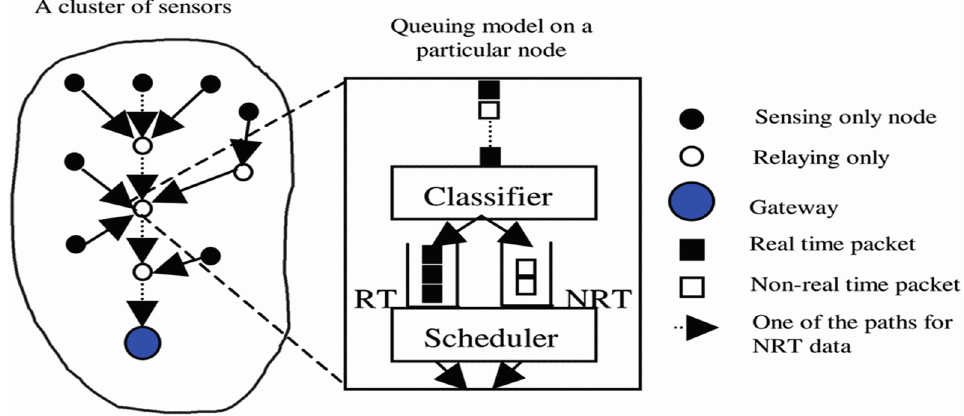
Figure 3. Queuing model in the cluster-based wireless sensor networks